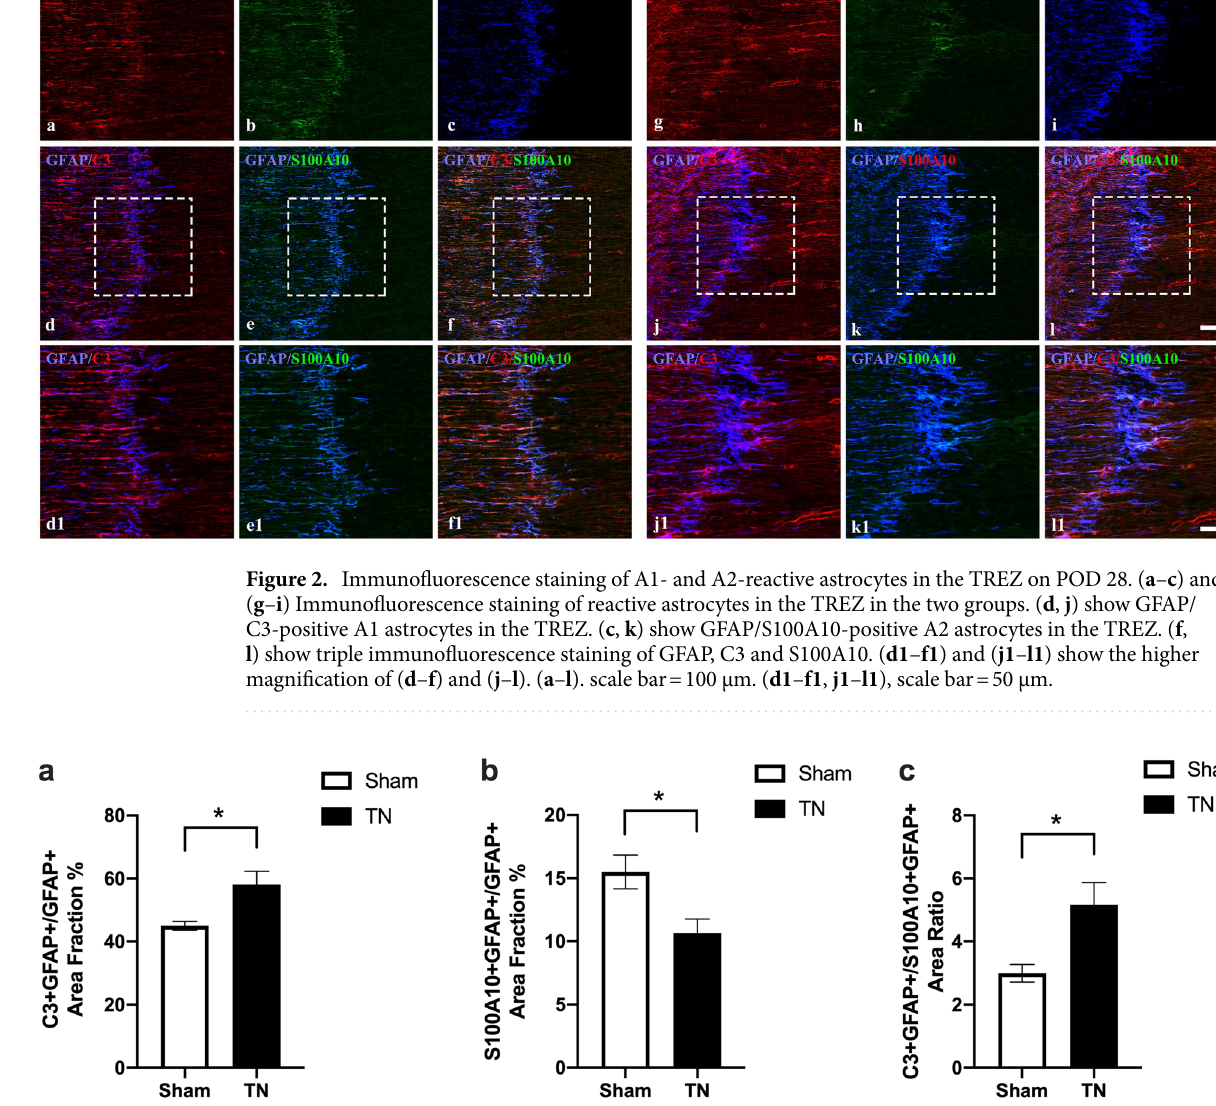
Figure 3. Quantitative analysis of C3 and S100A10 expression area in GFAP positive astrocytes in TREZ on POD 28. ( a ) Quantitative analysis showing significant up regulation of C3 in GFAP positive astrocytes on POD 28 in TN group compared to sham group. ( b ) Quantitative analysis showing significant lower expression of S100A10 in GFAP positive astrocytes on POD 28 in TN group compared to sham group. ( c ) The ratio of GFAP/ C3-positive area and GFAP/S100A10-positive area was clearly increased in TN group compared with sham group. Data represent mean ± s.e.m. (n = 4–5 per group). * p < 0.05, as determined two-tailed Student’s S100A10 (Fig. 2 and Fig. S1). And there was significant larger expression area of the C3 ( p = 0.0136) and obvious smaller expression area of the S100A10 ( p = 0.0304) in GFAP positive astrocytes in TREZ after chronic compres- sion. The ratio of GFAP/C3-positive area and GFAP/S100A10-positive area was clearly increased in TN group compared with sham group ( p = 0.0174) (Fig. 3). However, there was very little positive expression of Ki67 in the TREZ region (Fig. 4). According to the result of flow cytometry, there were no statistical differences in the ratios of total astrocytes (CD45 − GLAST + ) ( p = 0.05968), A1 astrocytes (CD45 − GLAST + C3 + ) ( p = 0.1599) and A2 astrocytes (CD45 − GLAST + S100A10 + ) ( p = 0.7788) between the two groups (Fig. 5). Different expression of immune cells in the TREZ after compression injury. According to the immunohistochemical staining results, there was no significant difference in Iba-1-positive cells between the